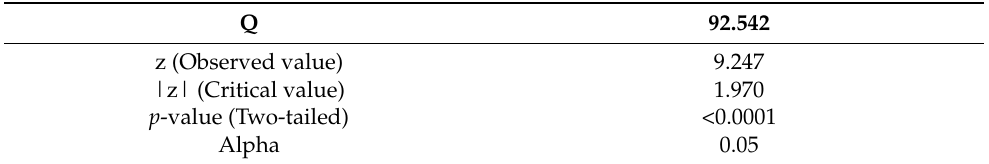
Table 8. McNemar test for the impact of intensifying the implementation of ICT in the work of the manager.